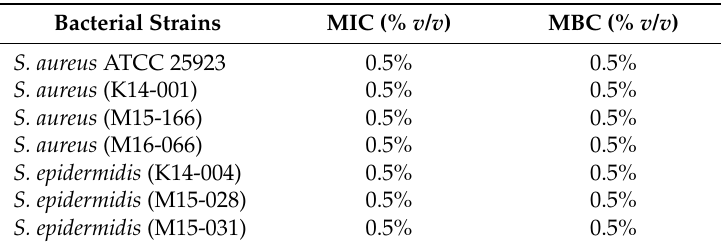
Table 1. The MIC and MBC of lactic acid against staphylococcus species of three independent experiments performed in duplicate by broth microdilution